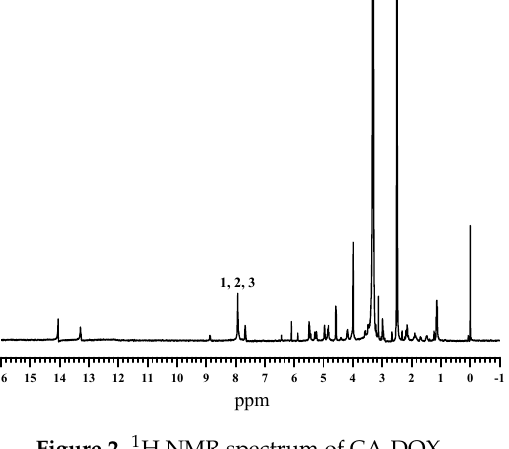
Figure 2. 1 H NMR spectrum of CA-DOX.